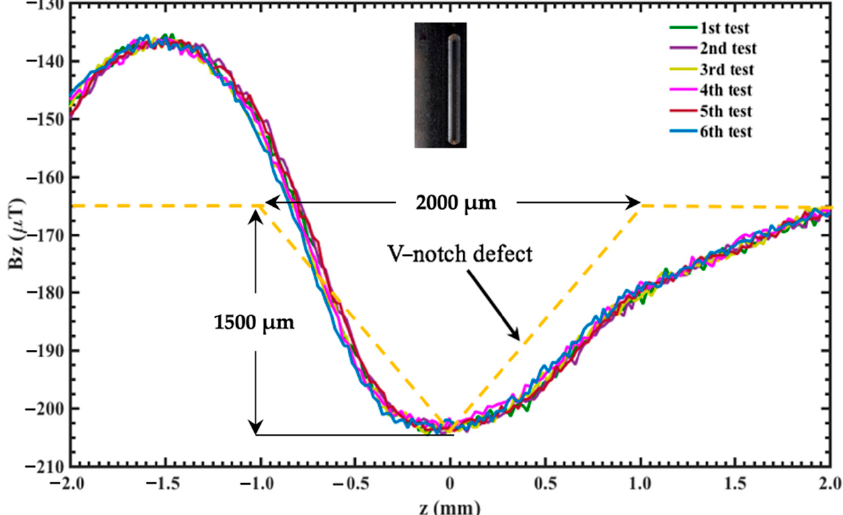
Figure 7. Variation of tangential MMM signals measured around the third V-shaped notch (2000 µm width and 1500 µm depth) of the ASTM-A36 steel pipe, which were measured using six experimental tests.